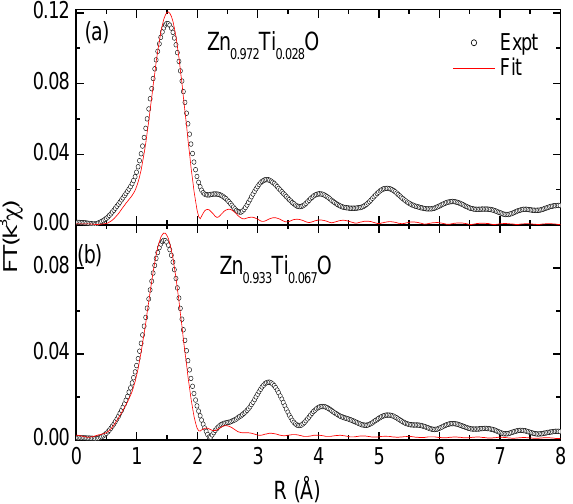
Ti and 0.972 0.028